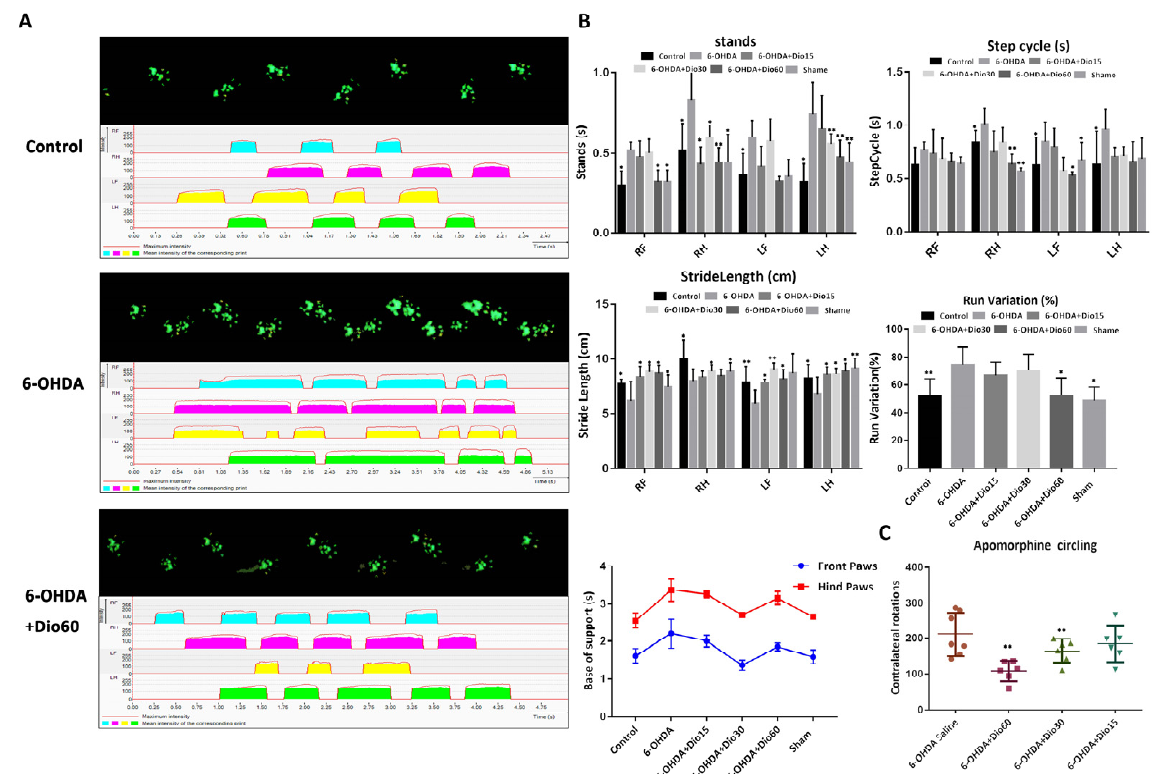
Figure 4. Regulation effect of dioscin gait on 6-hydroxydopamine (6-OHDA)-induced rats. ( A ) Effects of dioscin on walking pattern and individual paws (RF: right front, RH: right hind, LF: left front, and LH: left hind). The upper panel (green prints in black background) showed the digitized prints, while the lower panel (with colorful phase lags) showed the stance phase duration of each individual paw in a single step cycle. ( B ) Effects of dioscin on several parameters of CatWalk after 6-OHDA treatment. The stand phase, step cycle, stride length, run variation and base of support were tested. ( C ) Effects of dioscin on motor impairment by apomorphine-induced rotation test in rats. Data are expressed as mean ± SD ( n = 6). * p < 0.05 and ** p < 0.01 compared with the rats in the 6-OHDA group.